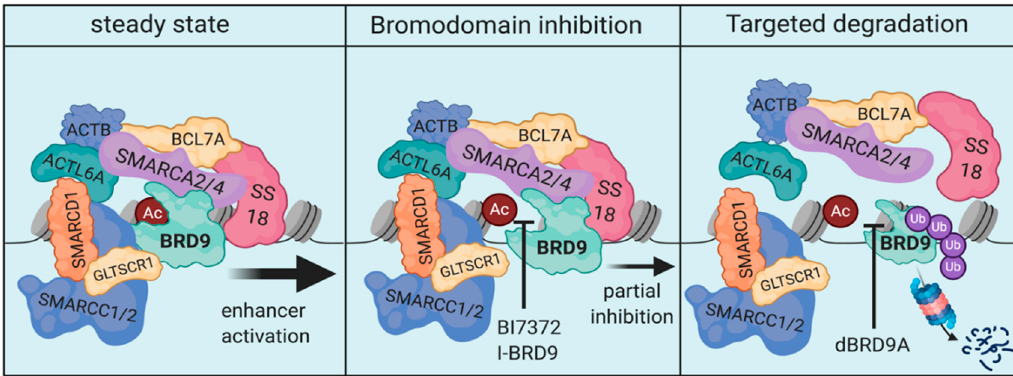
Figure 6. Schematic of the ncBAF-complex and the molecular consequences of BRD9-inhibition and BRD9-degradation. The chromatin remodeling function of the ncBAF complex is essential in maintenance of SS18-fusion driven synovial sarcoma ( left ). BRD9-bromodomain-inhibition leads to only a partial dissociation of the complex limiting cellular efficacy ( middle ). Targeted degradation of BRD9, on the other hand, de-stabilizes the complex to a greater extent, enabling increased cellular efficacy ( right ).